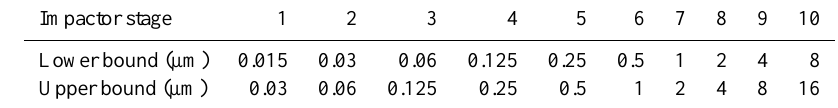
Table 1. The lower and upper bounds for each stage of the BLPI. They represent the 50% cut-off aerodynamic diameters. Impactor